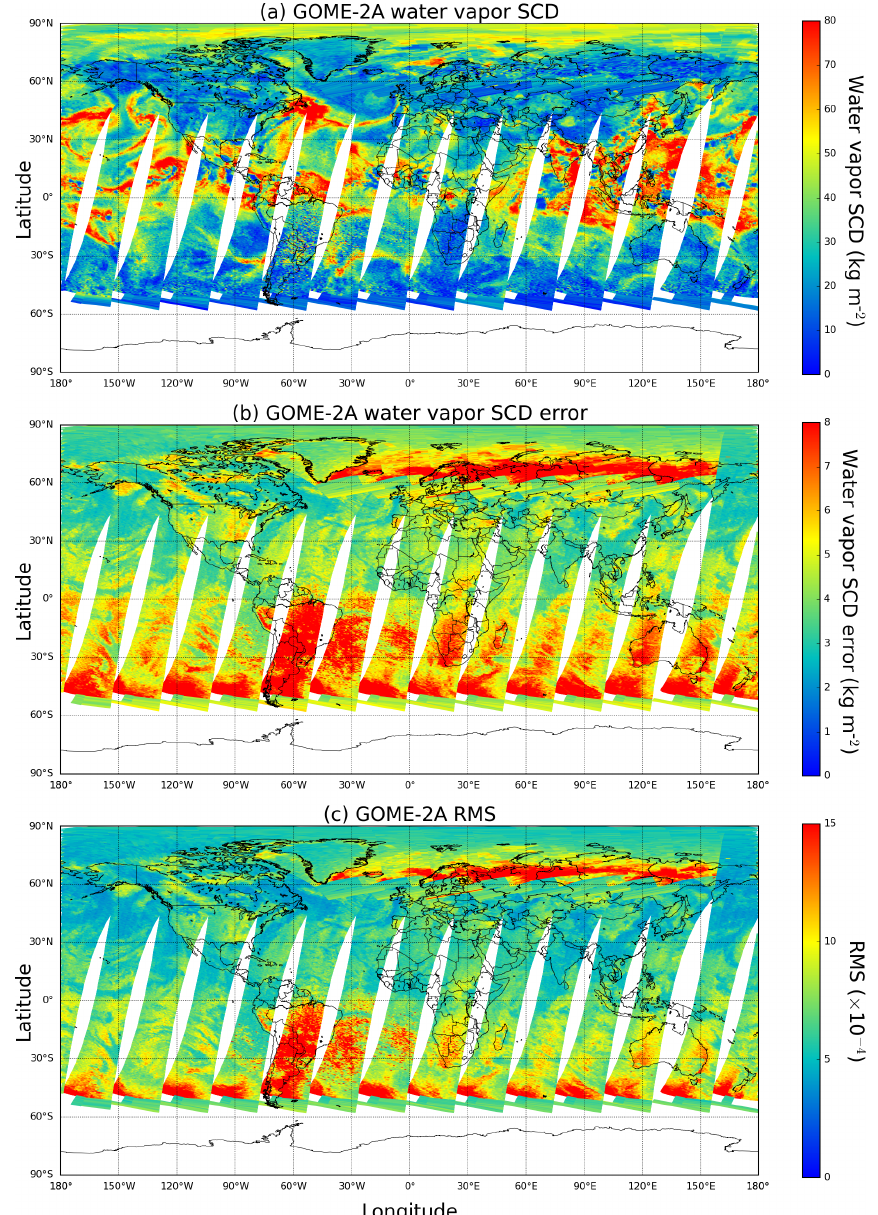
Figure 4. (a) Slant column densities of water vapor retrieved from GOME-2 observations on 1 July 2008 (orbit 8813–8826). (b) The corresponding water vapor slant column uncertainties and (c) the root mean square of the spectral fit residual.